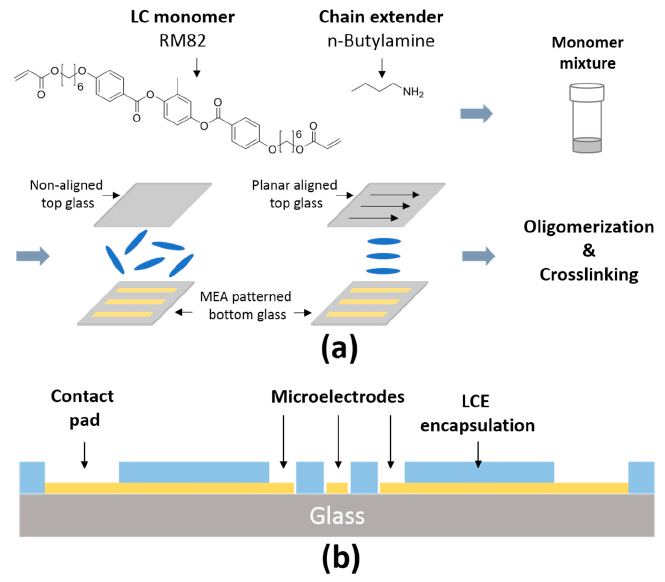
Figure 1. Chemistry of LCE and MEA fabrication: ( a ) Molecular structure of monomers used to synthesize the LCE and device fabrication procedure; ( b ) Cross-sectional schematic of LCE MEA devices.